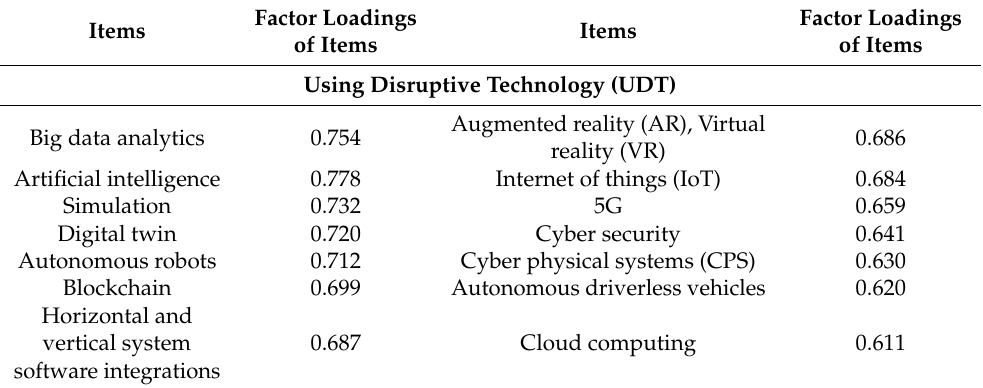
Table 11. Factor Loadings for EFA Model 3.